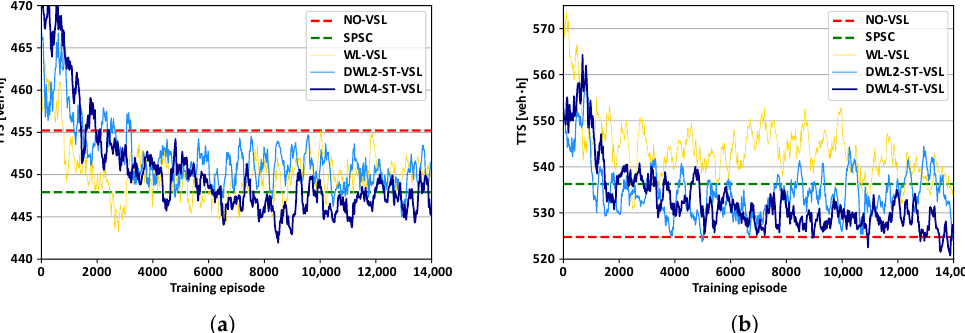
Figure 8. The convergence of TTS during the training process. ( a ) Medium traffic load scenario. ( b ) High traffic load